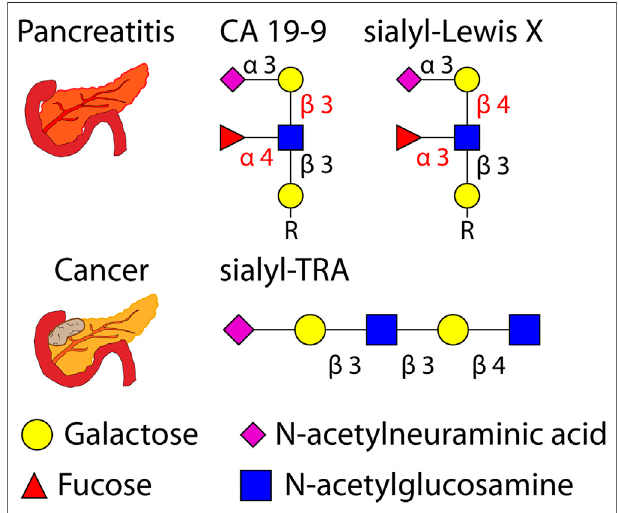
FIGURE 6 | Graphical depiction of pancreatitis, pancreatic cancer, and several related O-glycans (with glycosidic linkages shown) investigated as biomarkers. R (cid:1)